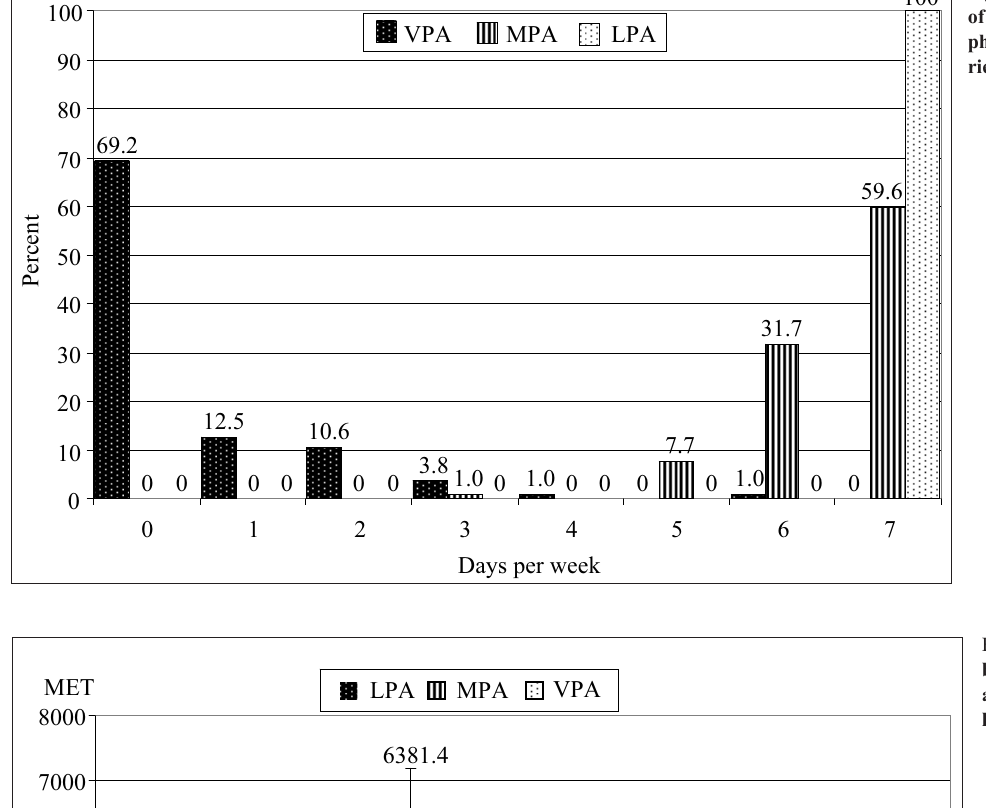
Figure 1. The frequency of different intensity